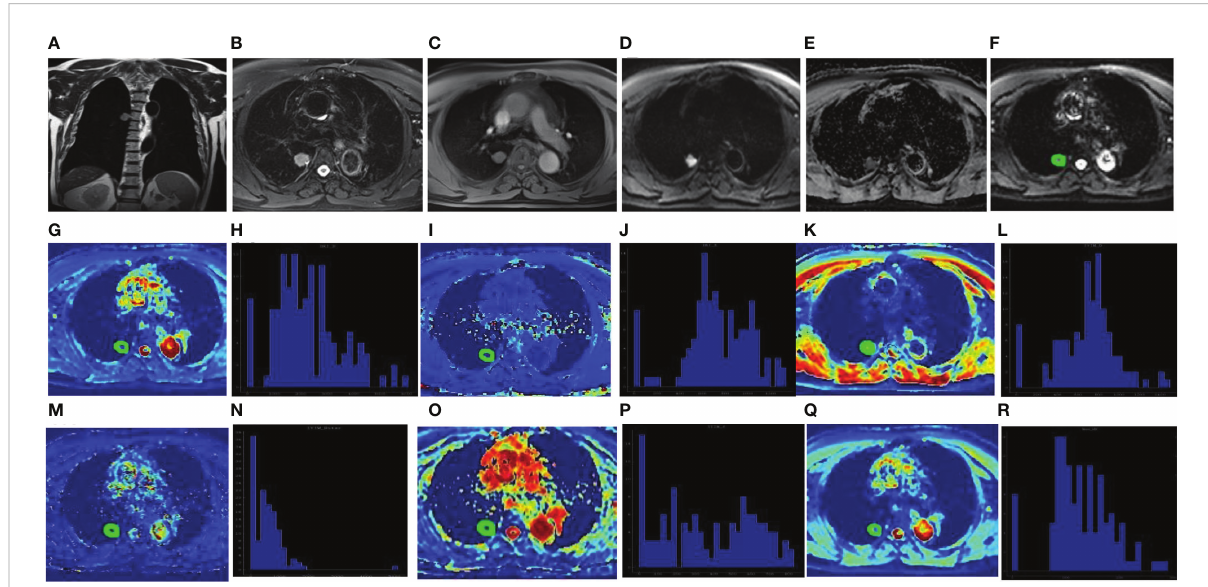
FIGURE 2 Male, 67 years old, the dorsal segment of right lower lobe showed solid SPN with a length of about 22mm. The pathological fi ndings were adenocarcinoma. Coronal T2WI showed Slightly higher signal (A) ; Axial T2WI and fat suppression sequence showed uneven slightly higher signal with rough edges and adjacent pleural depression (B) ; Axial T1WI showed isosignal (C) ; DWI showed high signal (D) and ADC value decreased (E) . The ROI was delineated layer by layer on the original image (F) in the DKI model, and then a VOI was synthesized and copied to the pseudo-color images of Dk (G) , K (I) , D (K) , D* (M) , f (O) and ADC (Q) . The whole-lesion histogram parameters of Dk (H) , K (J) , D (L) , D* (N) , f (P) and ADC (R) value were calculated. D* is one of the parameters of